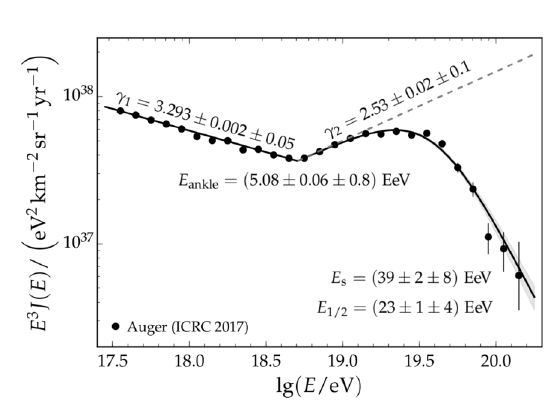
Figure 2. Combined energy spectrum. The line shows a fit to the spectrum with a broken power law and a suppression at ultra- high energies. The gray dashed line indicates the same broken power law without suppression. The fitted spectral indices and energies of the break and suppression are superimposed together with their statistical and systematic